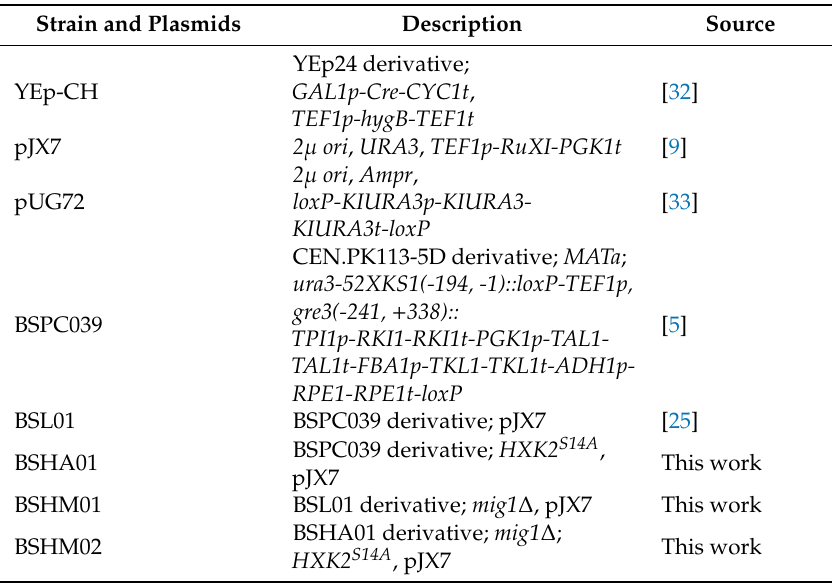
Table 1. Plasmids and strains used in this study Strain and